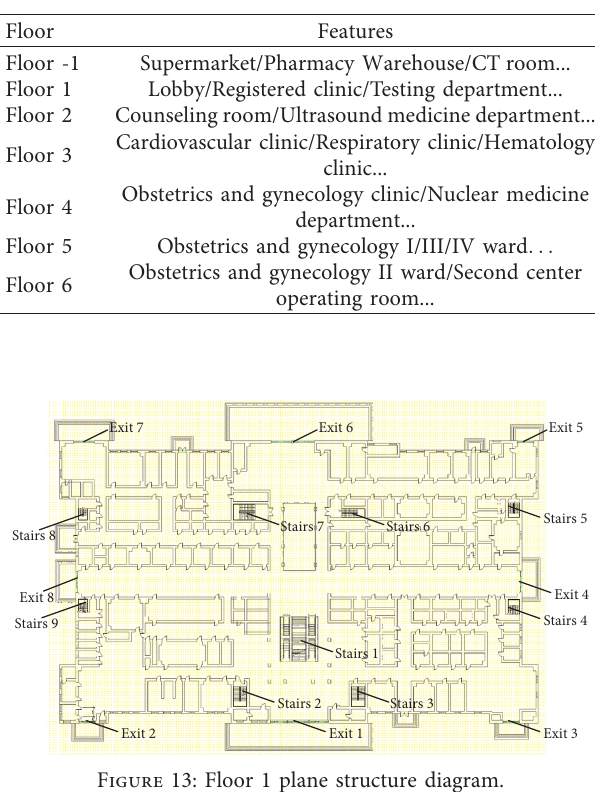
Table 15: Function distribution of each floor.